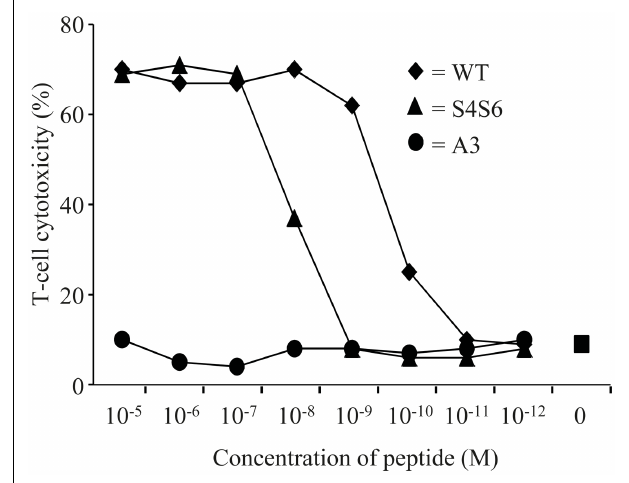
FIGURE 3 |The gp100APL S4S6 is able to induceT cell cytotoxicity . TCR-engineeredT cells were tested in a 51 Cr-release assay.T2 target cells were either non-loaded or loaded with titrated amounts of gp100 wt peptide (wt) or APLs A3 and S4S6 (range: 10 − 5 –10 − 12 M peptide).T cell cytotoxicity was assayed after 6h with an effector to target cell ratio of 30:1, after which specific lysis was calculated. Results of one (out of two) representative experiment are shown based on the mean value of triplicate data